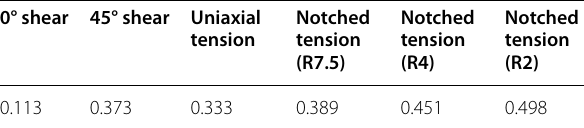
Table 4 Average stress triaxiality of specimens under different stress